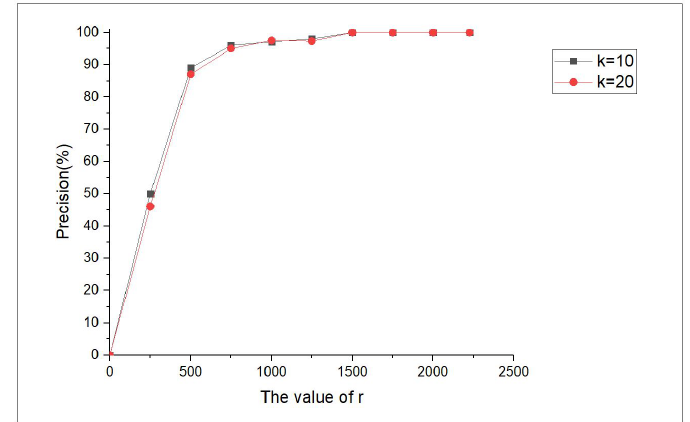
Figure 2. The effects on different value of r